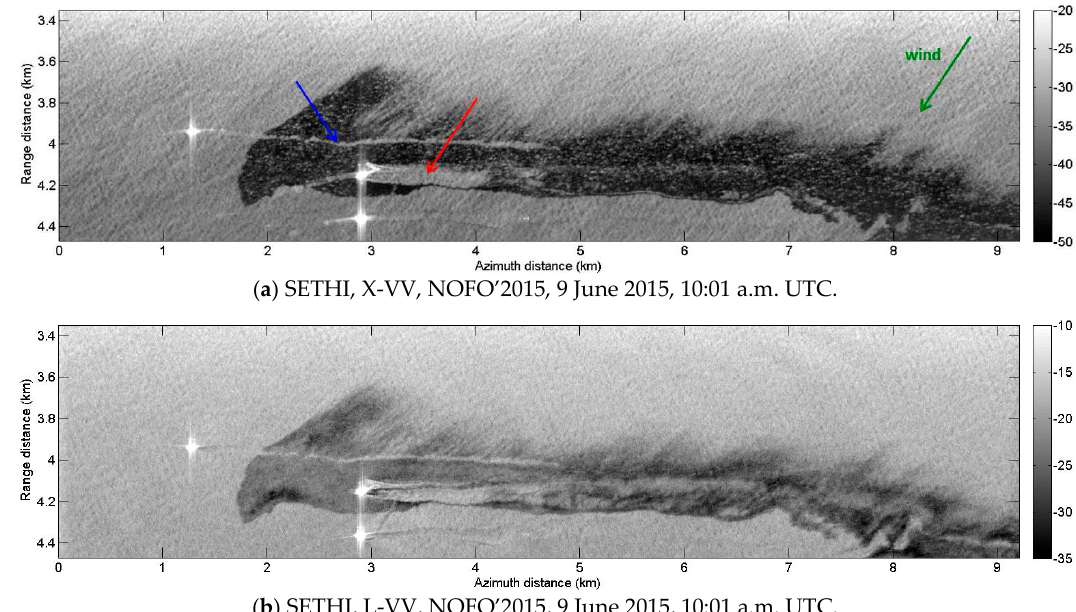
Figure 15. SETHI NOFO’2015 (run 8)—SAR data over mineral oil on 9 June 2015 at 10:01 a.m. UTC: ( a ) X-band VV-pol and ( b ) L-band VV-pol (multi-look 7 × 7—scale in dB).